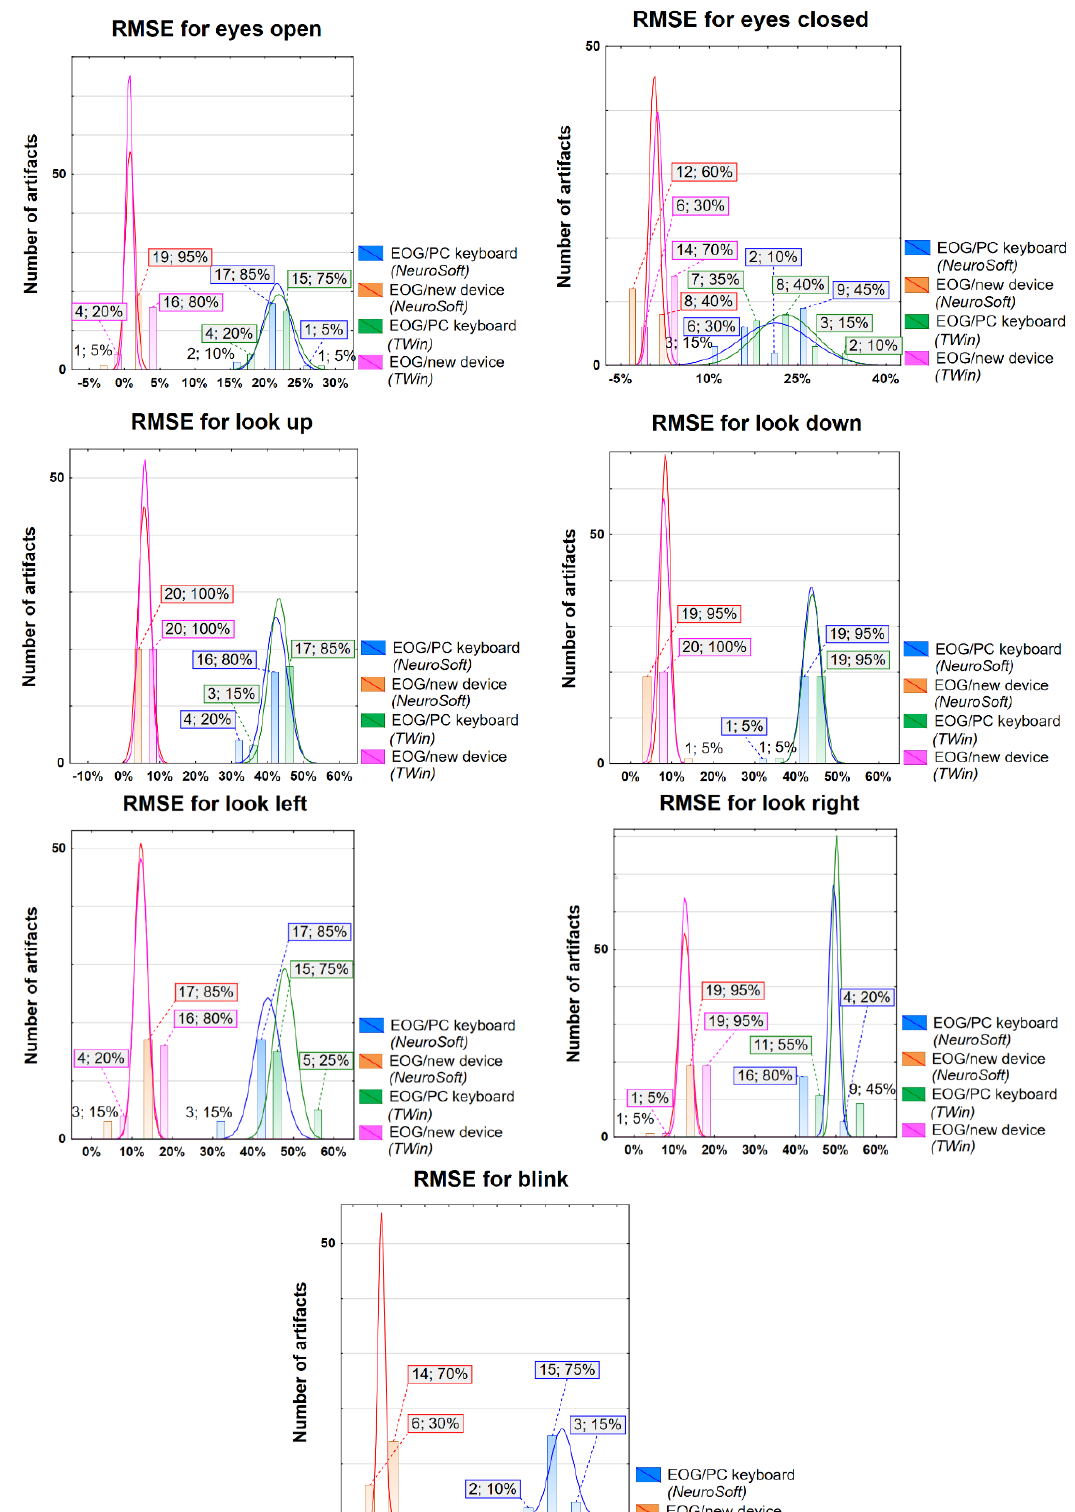
Figure 5. The differences between the EOG and the peripheral devices (i.e., the PC keyboard and new device) calculated by the root mean square error (RMSE). The analysis was prepared for 20 randomly selected ocular artifacts of each type (i.e., eyes open, eyes closed, horizontal and vertical eyes movements, blink). The X axis represents the percentage value of the RMSE and the Y axis represents the number of artifacts. The graph includes additional information about the number of artifacts—also expressed in percentages, whose RMSE values are within the specified